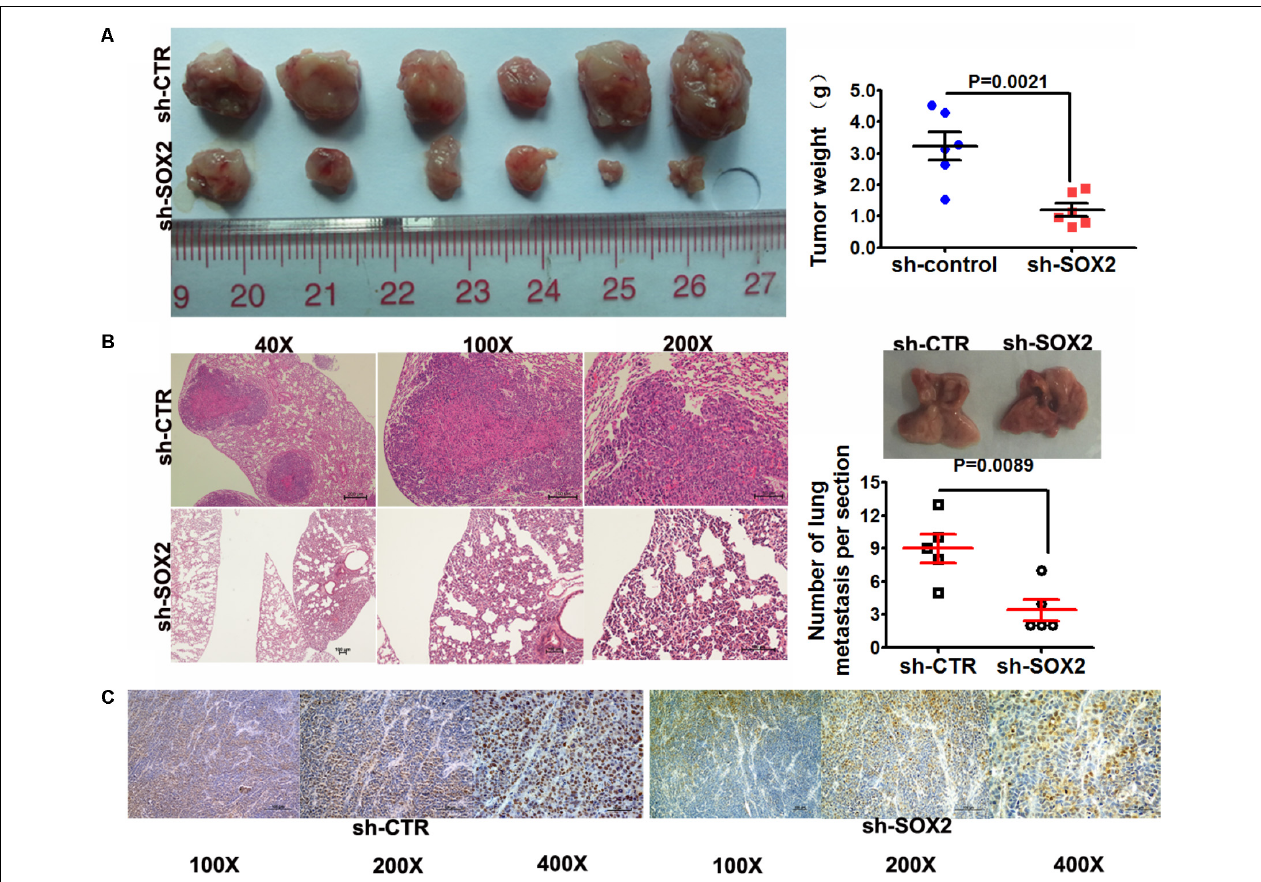
FIGURE 3 | SOX2 inhibition reduced tumorigenesis and metastasis in xenograft model. (A) Tumor xenografts in mice. MDA-MB-231 cells infected with sh-SOX2 or sh-control were subcutaneously injected into nude mice (6 in each group). 28 days later, the mice were sacrificed and dissected, and the tumors were weighed. (B) Tumor metastasis in mouse xenograft models. MDA-MB-231 cells infected with sh-SOX2 or sh-control lentivirus were injected into the tail vein of nude mice (5 in each group). 28 days later, the mice were sacrificed and micrometastases in the lung per HE-stained section from individual mice were calculated. (C) Expression levels of SOX2 in the mouse xenograft model. The expression level of SOX2 in the sh-SOX2 group was significantly lower than that in the sh-CTR group.